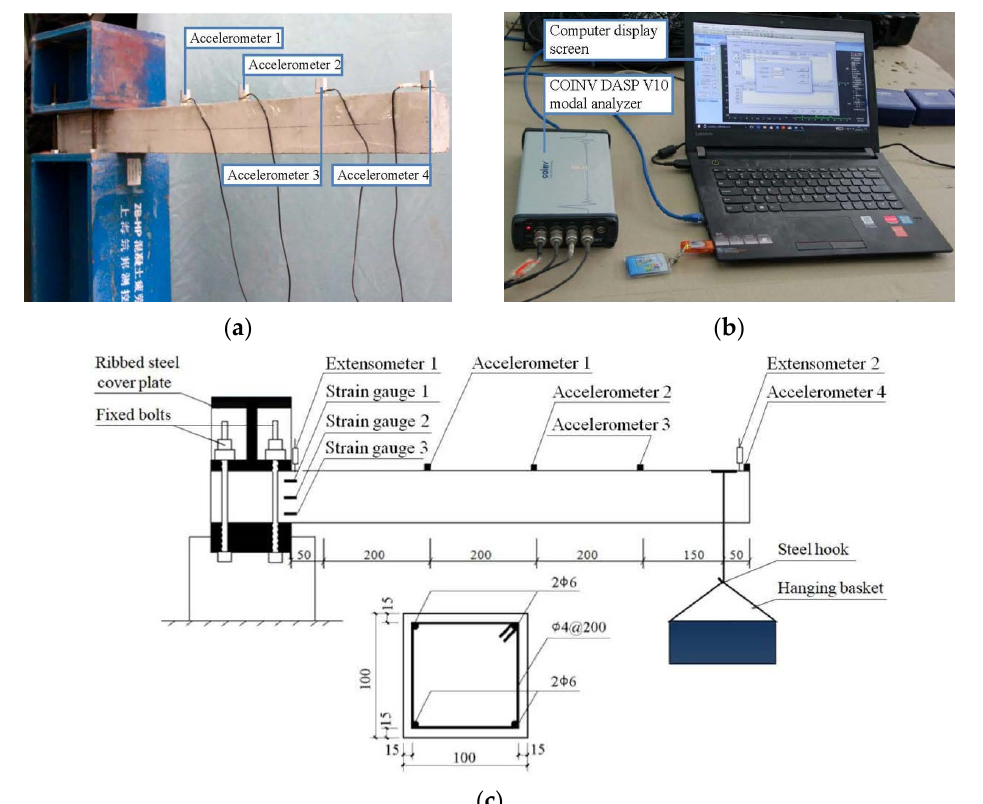
Figure 4. Test setup of free vibration and dynamic digital signal processing instrument: ( a ) Test setup of the cantilever beam; ( b ) Dynamic digital signal processing instrument; and ©( c ) Details of the test setup.